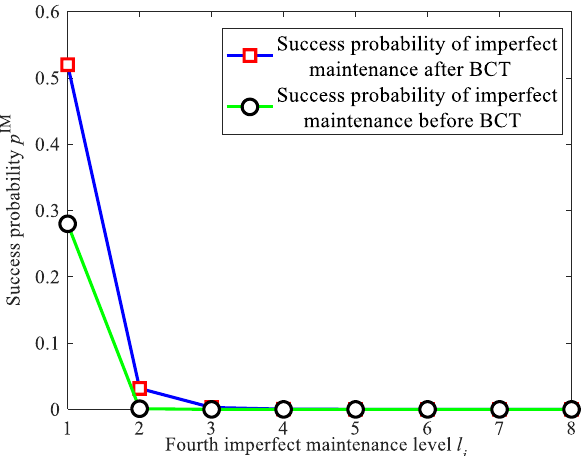
Figure 9. Probability of fourth imperfect maintenance to different levels .